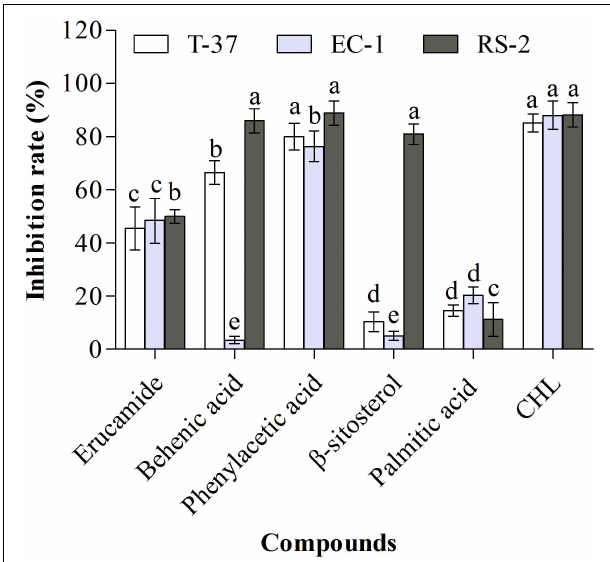
FIGURE 4 | Antibacterial activities of the monomeric compounds against the test bacteria. T-37, EC-1, and RS-2 represent Agrobacterium tumefaciens T-37, Erwinia carotovora EC-1, and Ralstonia solanacearum RS-2, respectively. CHL represents chloramphenicol. Different lowercase letters indicate significant differences ( P <